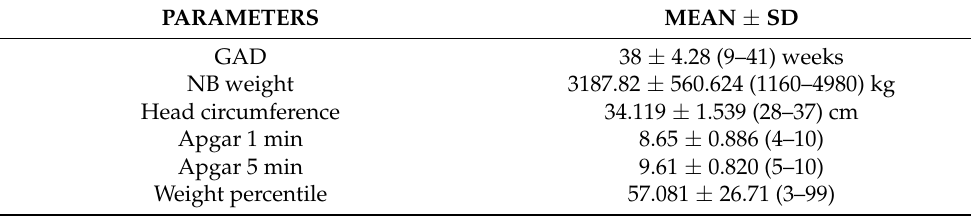
Table A5. Perinatal